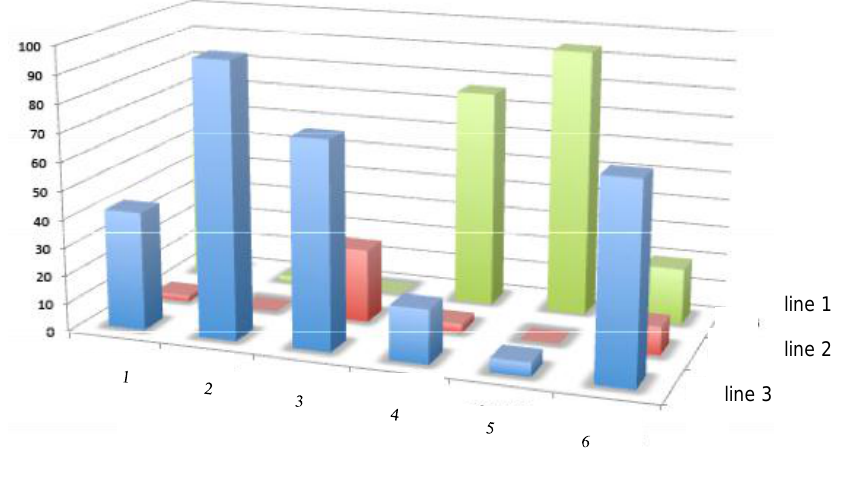
Fig.1. Graphic representation of mean squares’ relations (%).14 years old girls: line 1 — Х 1 (quantity of repetitions), line 2 — Х 2 (rest interval), line 3 — Х 1 Х 2 (interaction of quantity of repetitions and rest intervals)